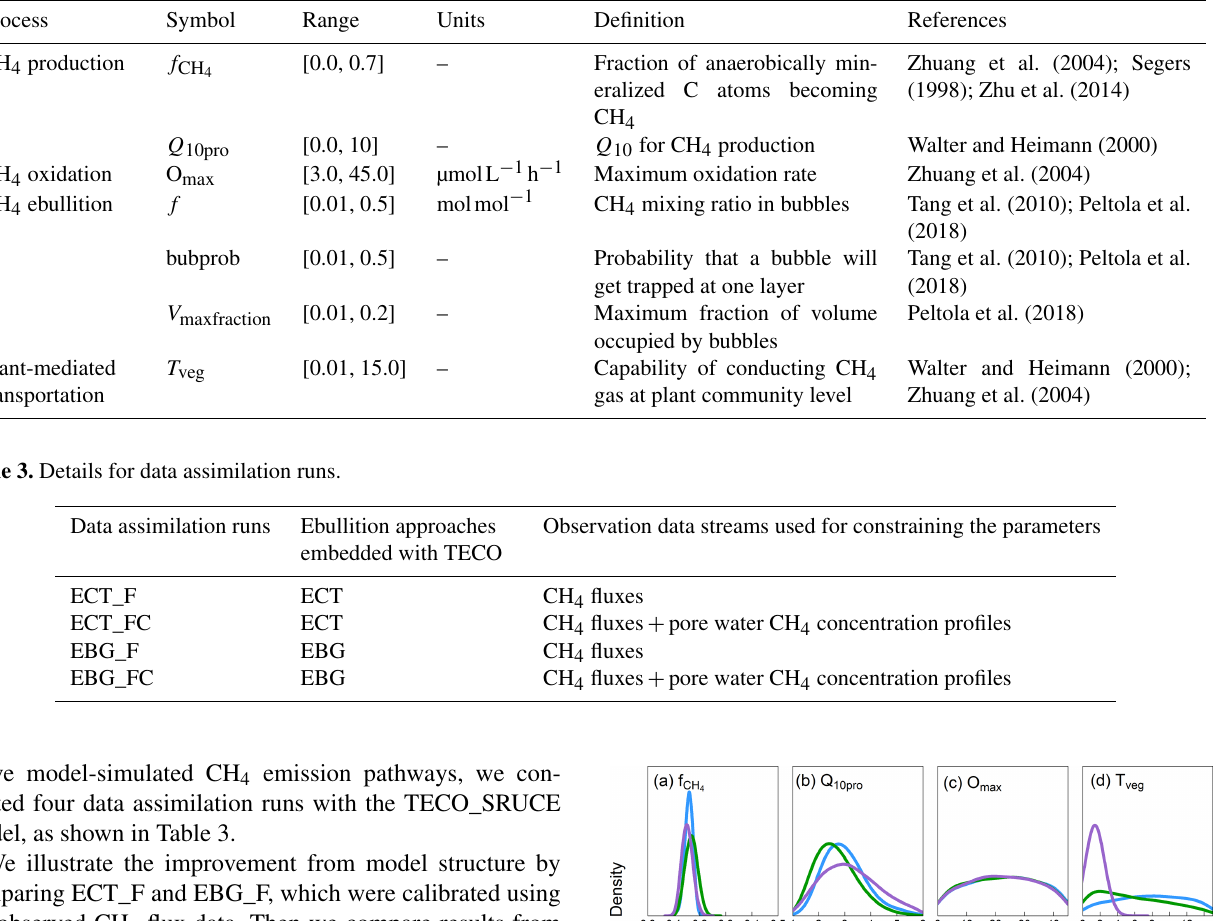
Table 2. Parameters used for data–model fusion.